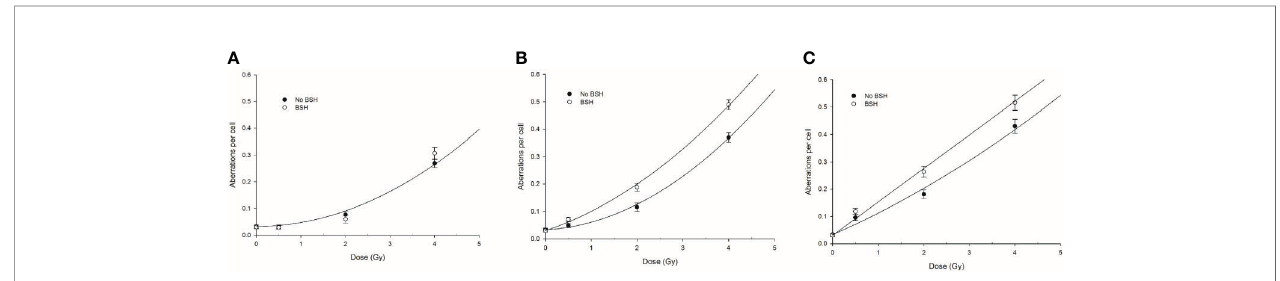
FIGURE 8 | CA frequency measured by WCP analysis in cells exposed along the CNAO proton beam SOBP: left panel (A) refers to entrance position, central panel (B) to mid-SOBP, and right panel (C) to distal SOBP. Error bars depict SE of at least three independent replicates. Data were fi tted to a linear-quadratic function Y=Y 0 + a D+ b D 2 .